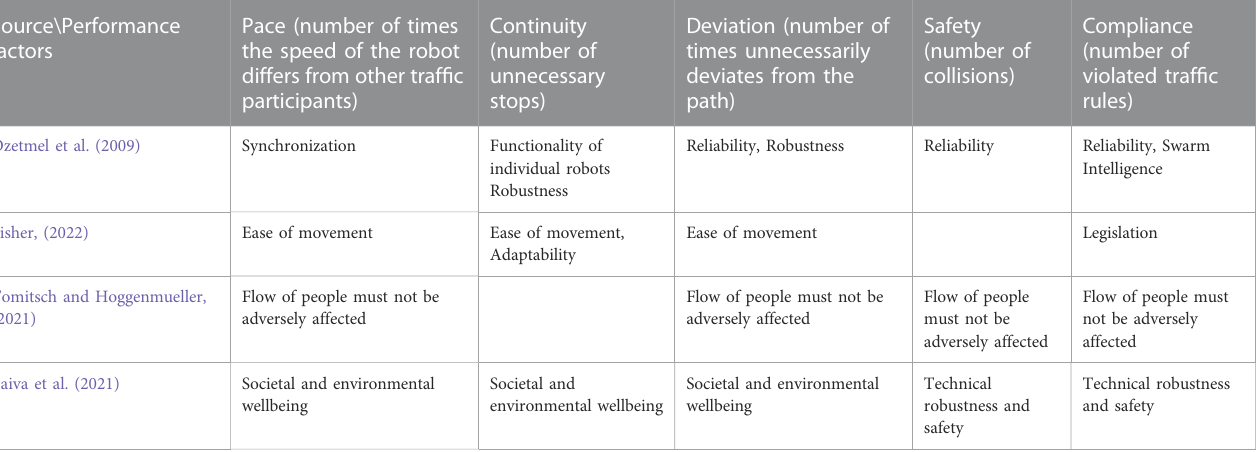
TABLE 1 Measurable performance factors derived from the literature